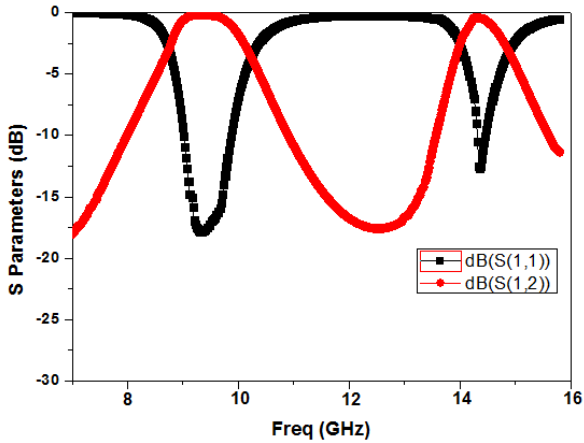
Figure 5. Frequency response of HMSIW integrated with hybrid fractal.